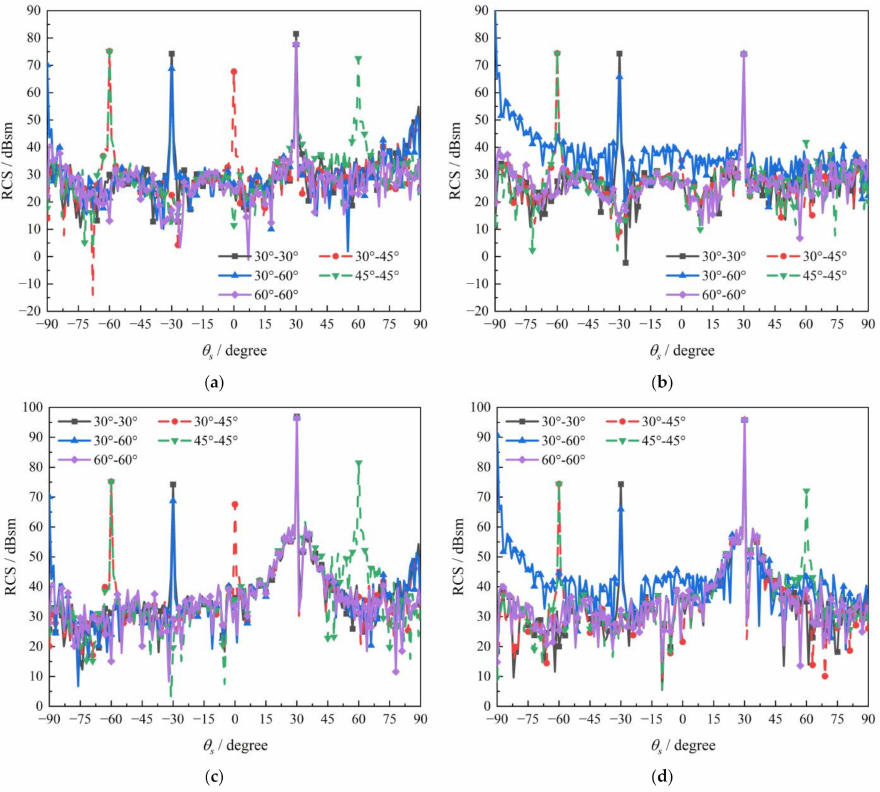
Figure 15. Bistatic RCS simulation results: ( a ) canyon, HH-polarization; ( b ) canyon, VV-polarization; ( c ) valley, HH-polarization; ( d ) valley,